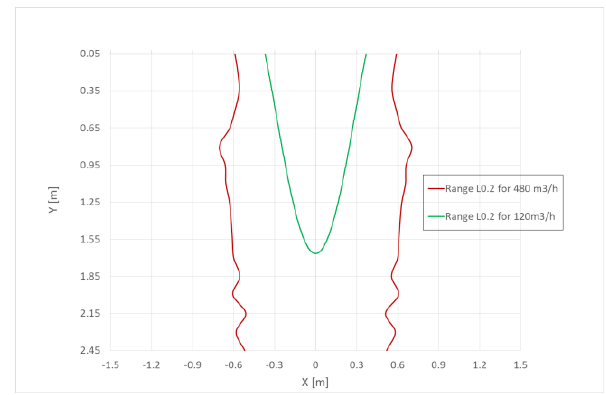
Fig. 11 . Range L0.2 of NSAL diffuser flow, with the downward flow, in the X-axis.